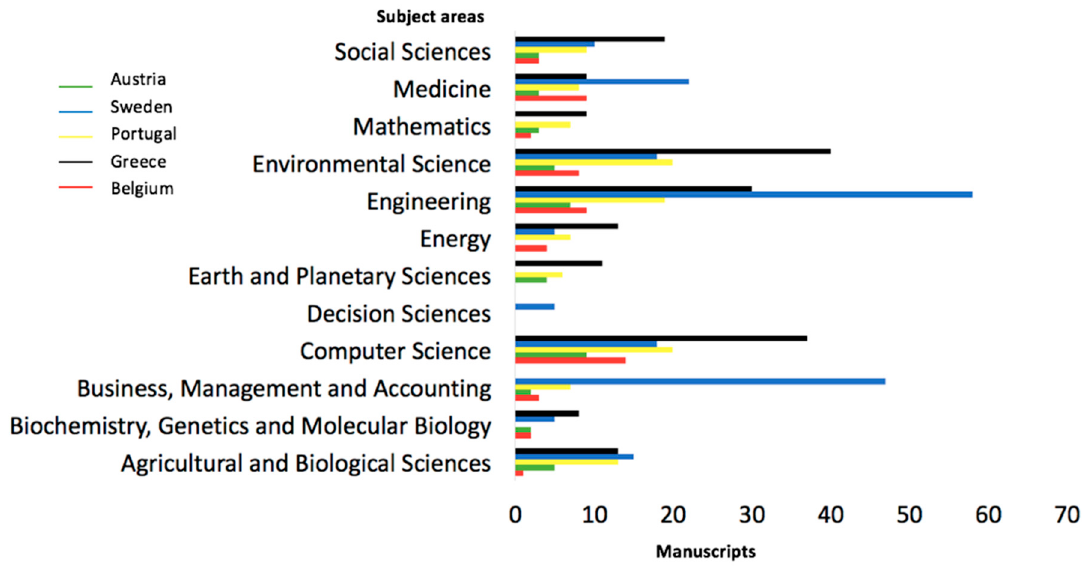
Figure 3. Documents by subject areas (Top 10).